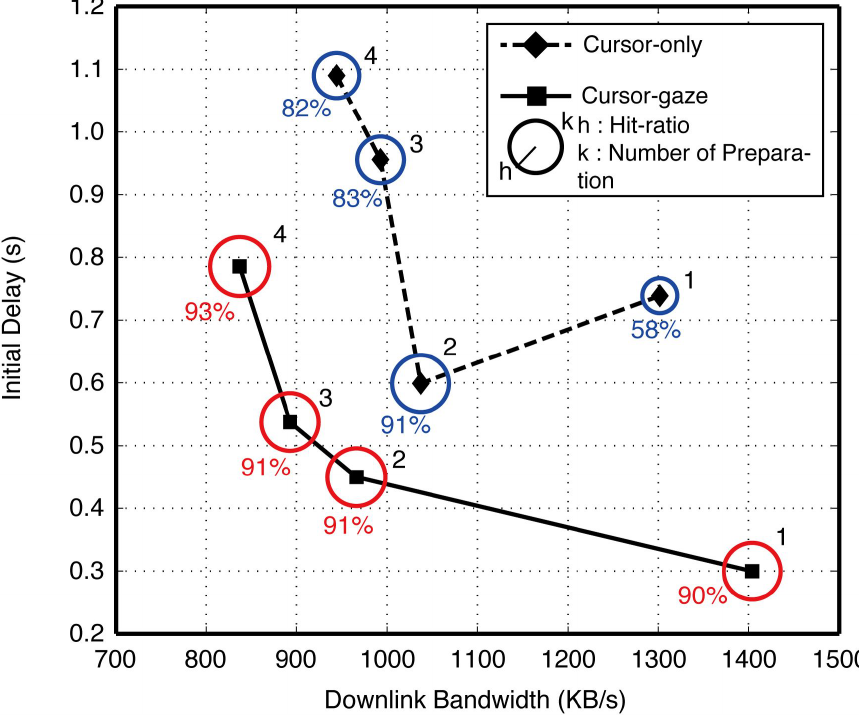
Figure 10. Initial delay and downlink bandwidth according to the number of preparation